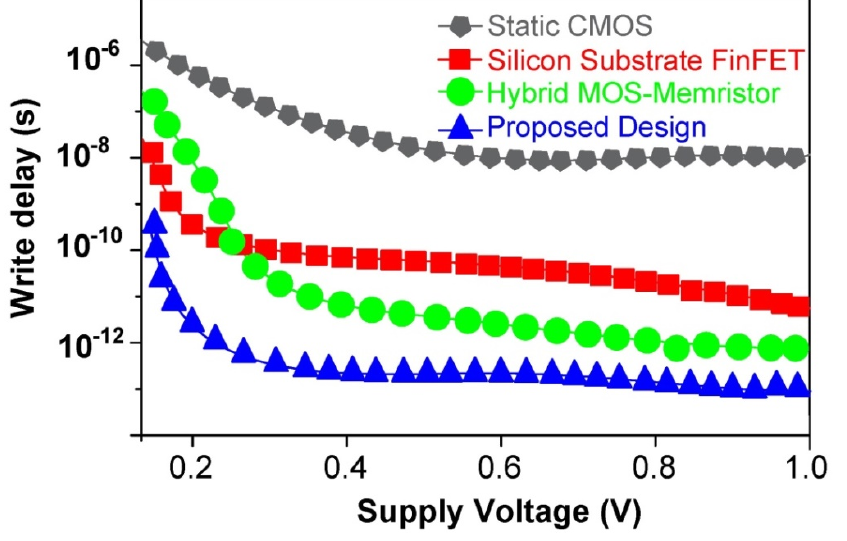
Figure 14. Write delay comparison of hybrid FinFET and Ti/SiO 2 /Si(n++)/TiN Memristor 6T-SRAM and traditional SRAM designs for various supply voltages.